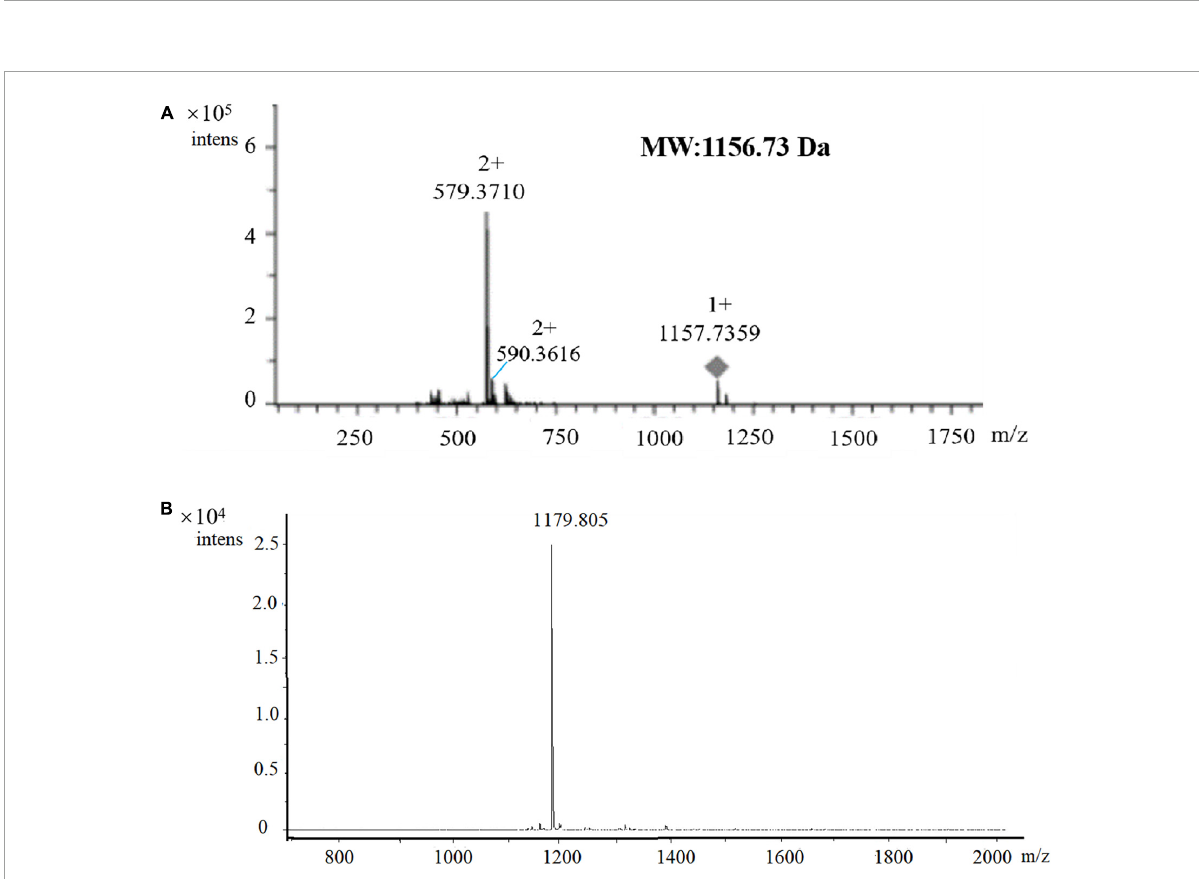
FIGURE5 Verification of the molecular mass and purity of the antimicrobial agent by LC-MS (A) and MALDI-TOF MS (B) analysis. m/z = 1179.805, which was inferred with [M + Na] + , the molecular mass of 1156.83 Da was